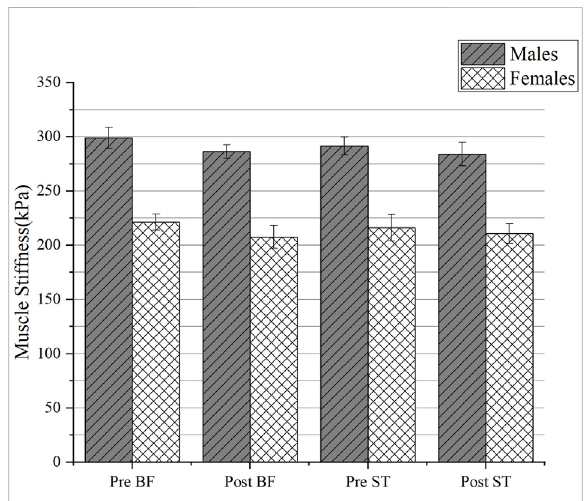
FIGURE 5 The change of fl exibility between genders. Abbreviations: the SR test, the sit-and-reach test; ROM, range of motion; Pre, pre- stretching; Post, post-stretching.